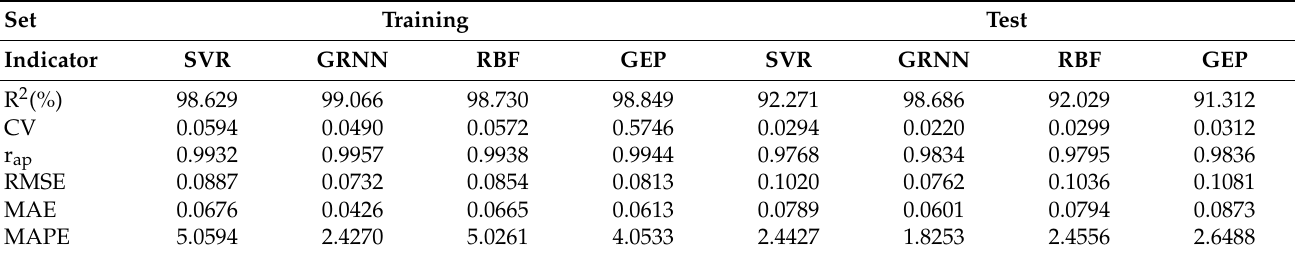
Table 5. The goodness of fit test for the bronze sample mass loss in the cavitation field.